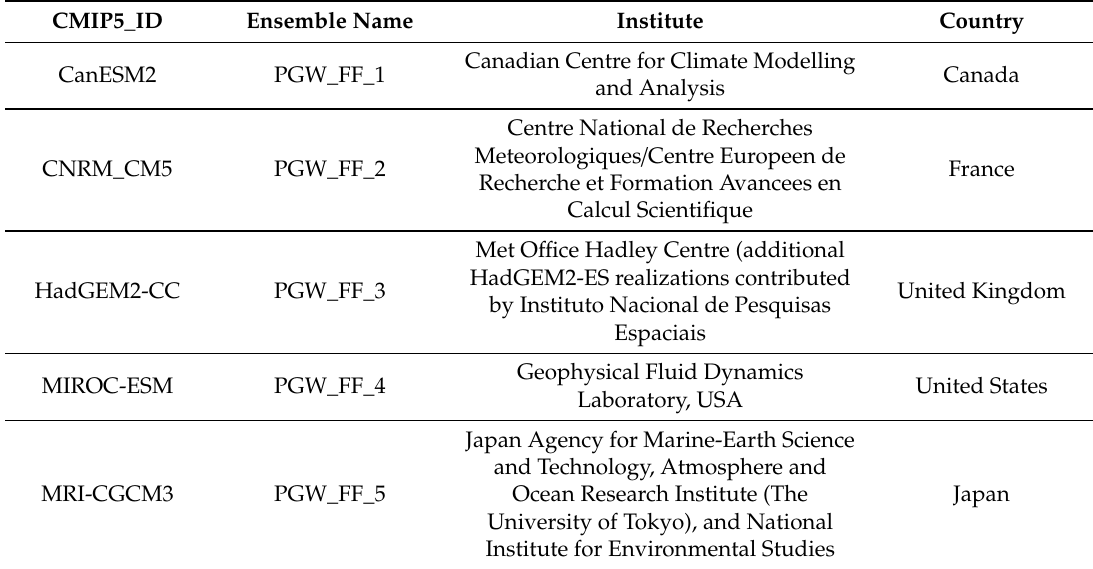
Table 1. List of the Climate Model Intercomparison Project (CMIP5) models used in the